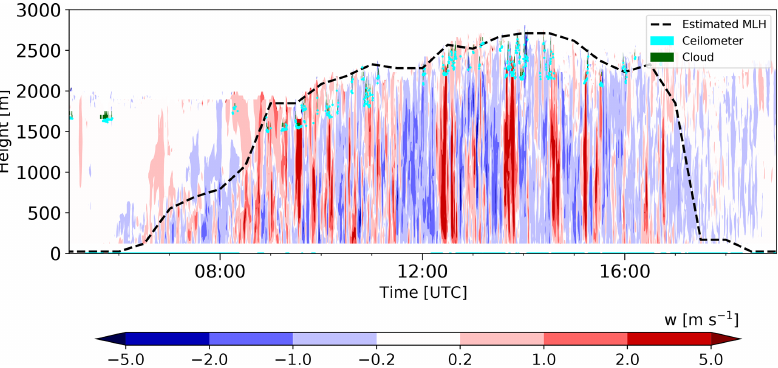
Figure 4. Vertical velocity averaged over 1min on 11 June 2021. The dashed black line indicates the estimated mixing-layer height based on the Doppler lidar measurements, the green dot shows the clouds from attenuated backscatter coefficient from the Doppler lidar, and the cyan dot indicates the cloud base height based on ceilometer